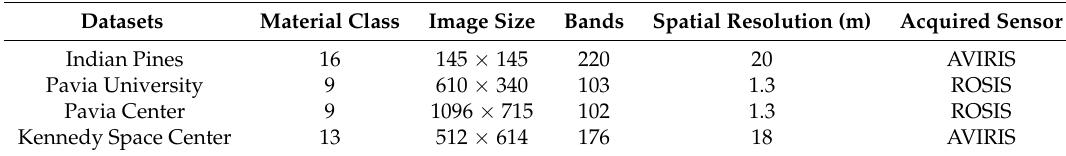
Table 2. Summaries for datasets used for HSI